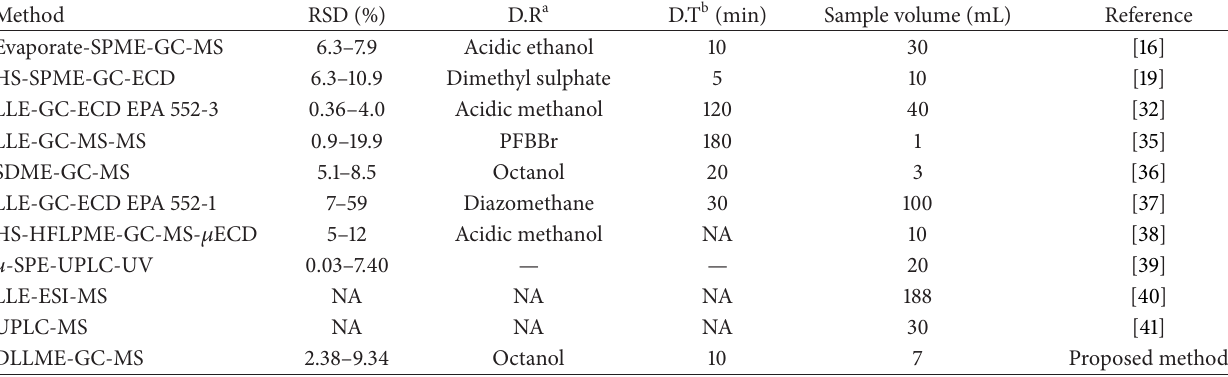
Table 2: Comparison between proposed method and methods reported in the literature for HAAs determination in water.